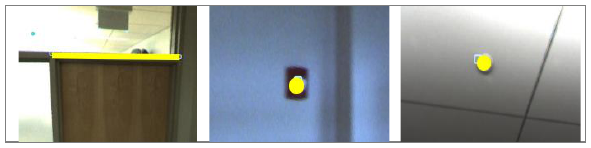
Figure 3 : Representation of example feature types as lines or points (yellow) in Retrace including door (left), fire alarm (middle), and smoke detector